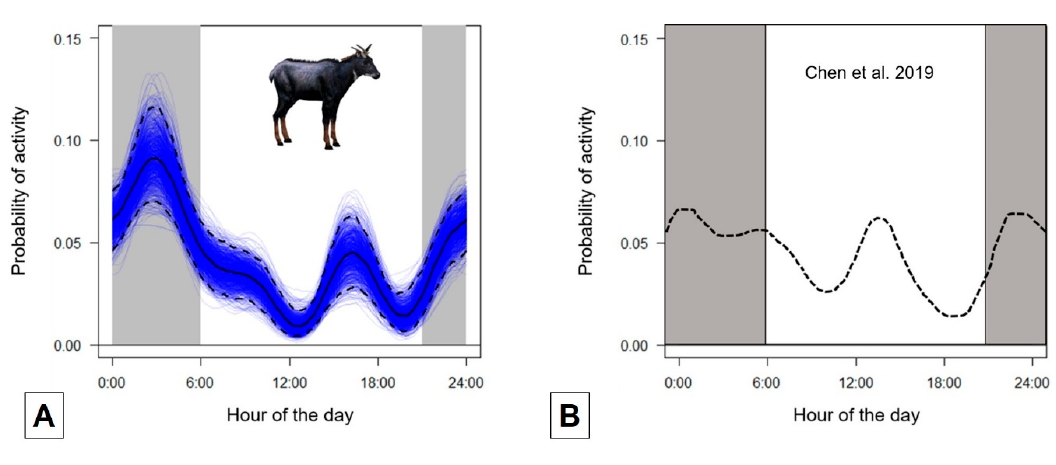
Figure 2. ( A ) Activity patterns of captive mainland serow, expressed as kernel density estimates throughout the 24 h ( n = 152 records). The solid black line shows the average trend, dashed black lines represent 95% confidence intervals. Blue lines show bootstrapped estimates of activity patterns. ( B ) Activity patterns of free-ranging mainland serow (from [23], modified).